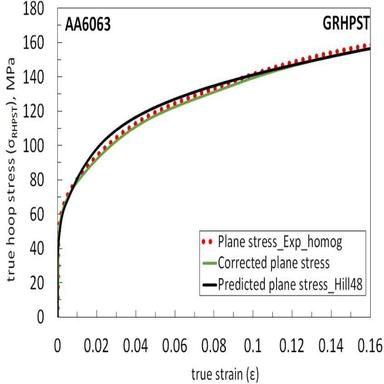
Comparison of the experimental GRHPST stress–strain curve (solid red dots), the GRHPST-corrected curve, and the predicted curve simulated using the Hill48 yield criterion.